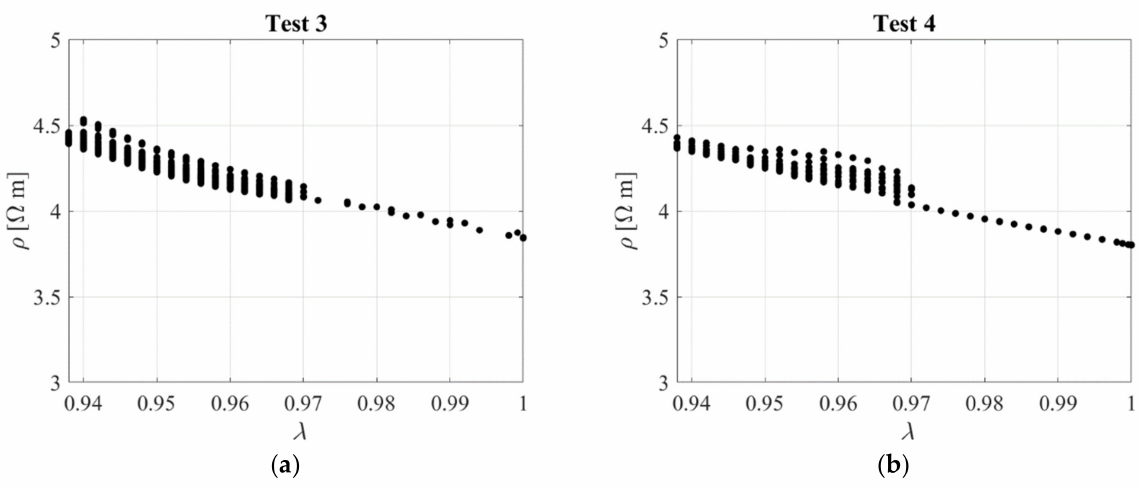
Figure 24. Resistivity against compression ratio: ( a ) Test 3 and ( b ) Test 4. Specimen with l 0 / d 0 =